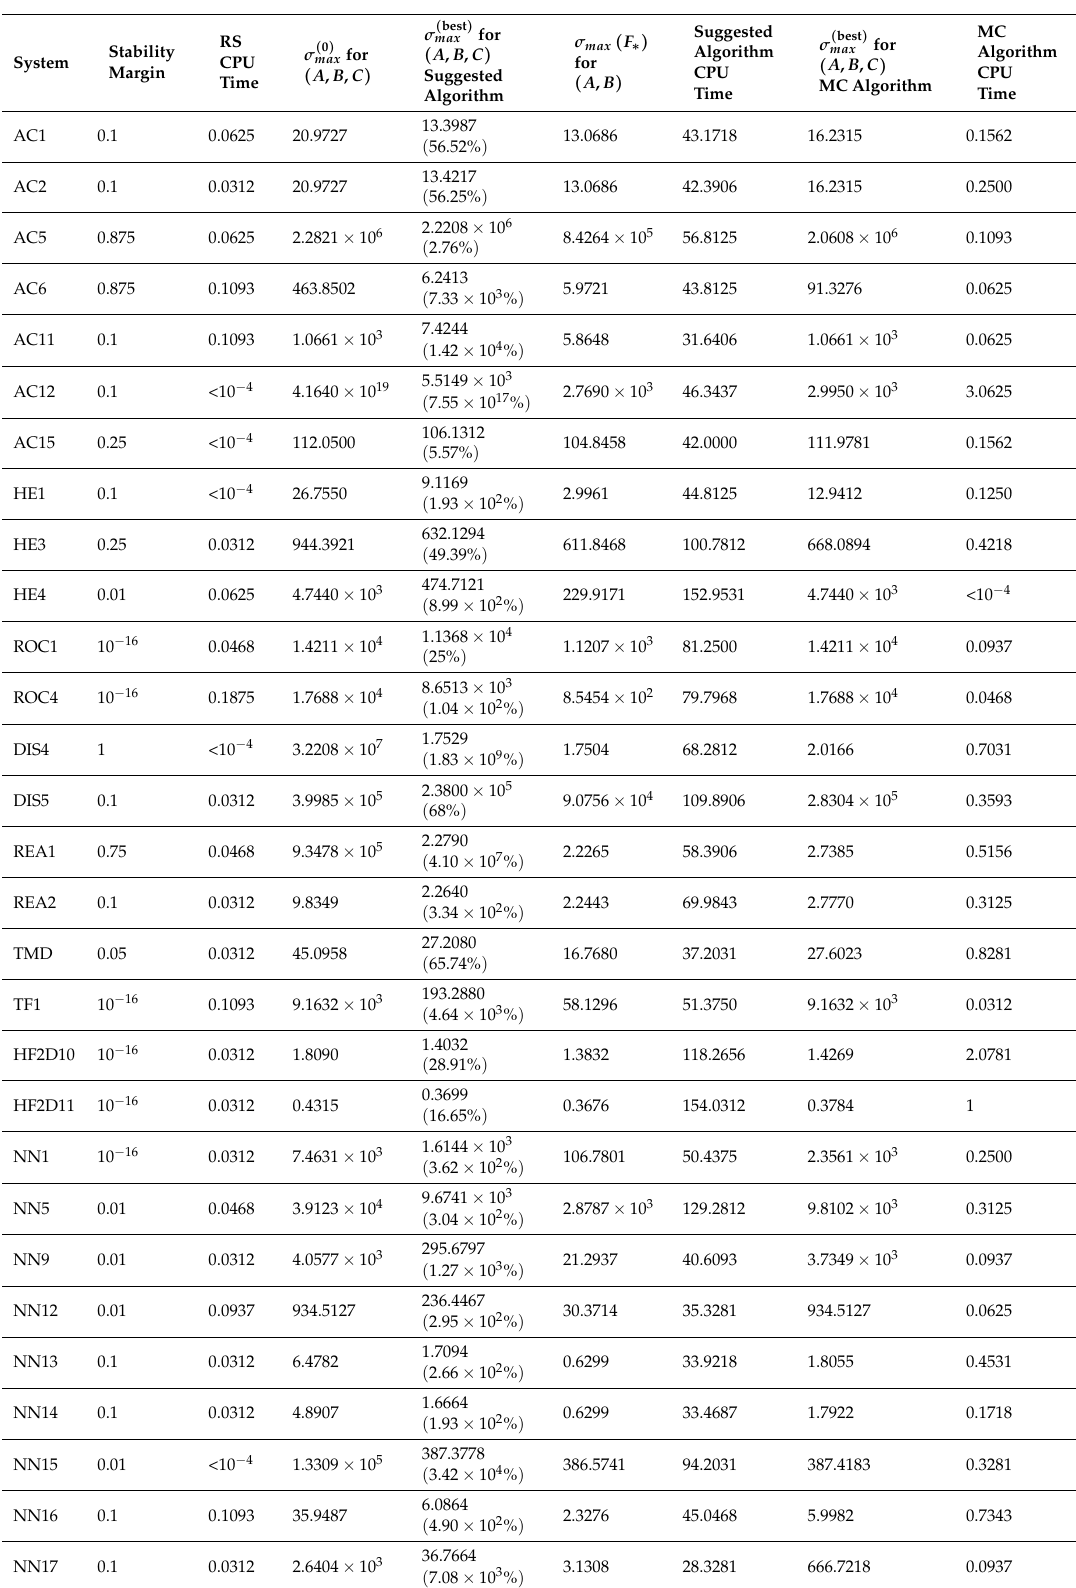
Table 1. Results of the suggested randomized algorithm for LQR via SOF compared with the results of the MC